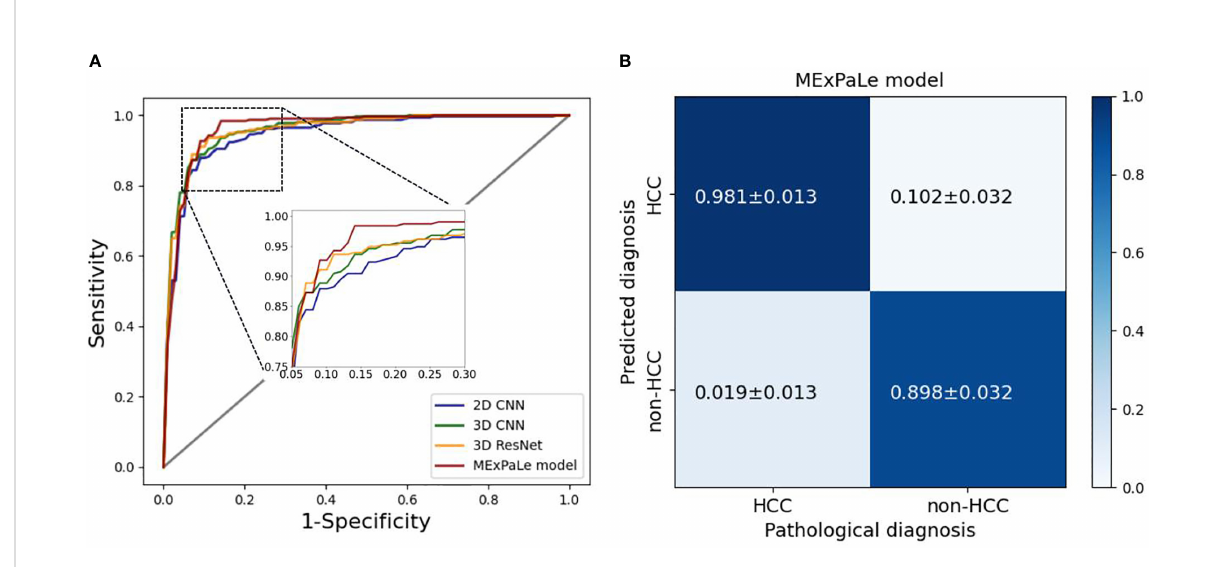
FIGURE 6 Performance of models. (A) ROC curves of models, (B) The confusion matrix of our MExPale model. HCC, hepatocellular carcinoma.